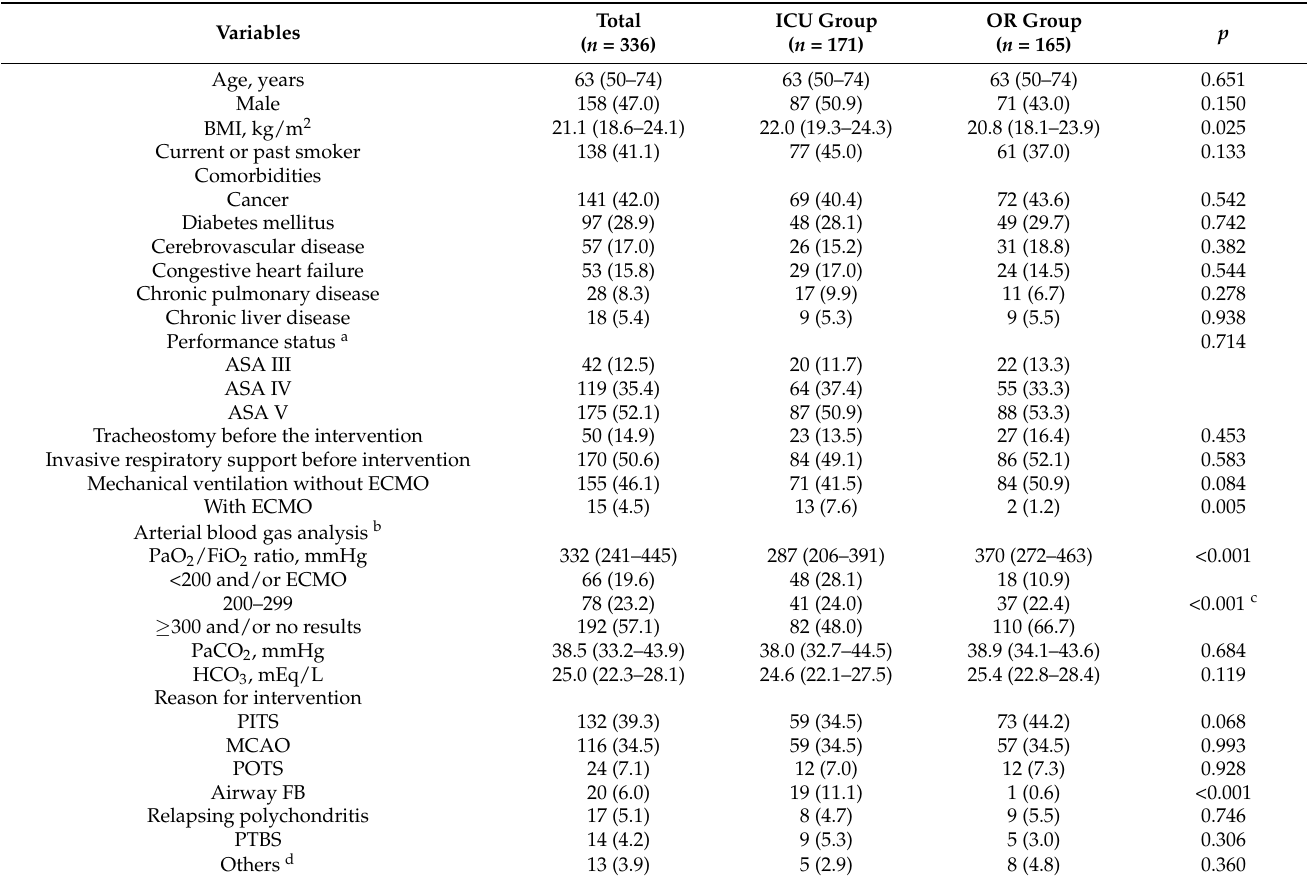
Table 1. Baseline